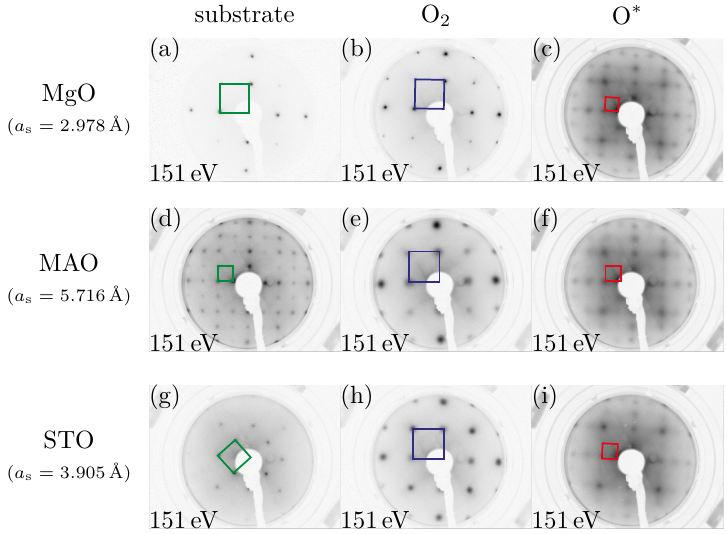
Figure 1. LEED patterns recorded at 151eV for the substrates (first column: ( a , d , g ), the films prepared with O 2 (second column: ( b , e , h )) and the films prepared with O ∗ (third column: ( c , f , i )). a s are the surface lattice constants of the respective substrates. The squares represent reciprocal surface unit cells. The films prepared using O 2 showed a ( 1 × 1 ) surface structure, which is too large to be a spinel structure, whereas the films prepared using O ∗ showed a spinel